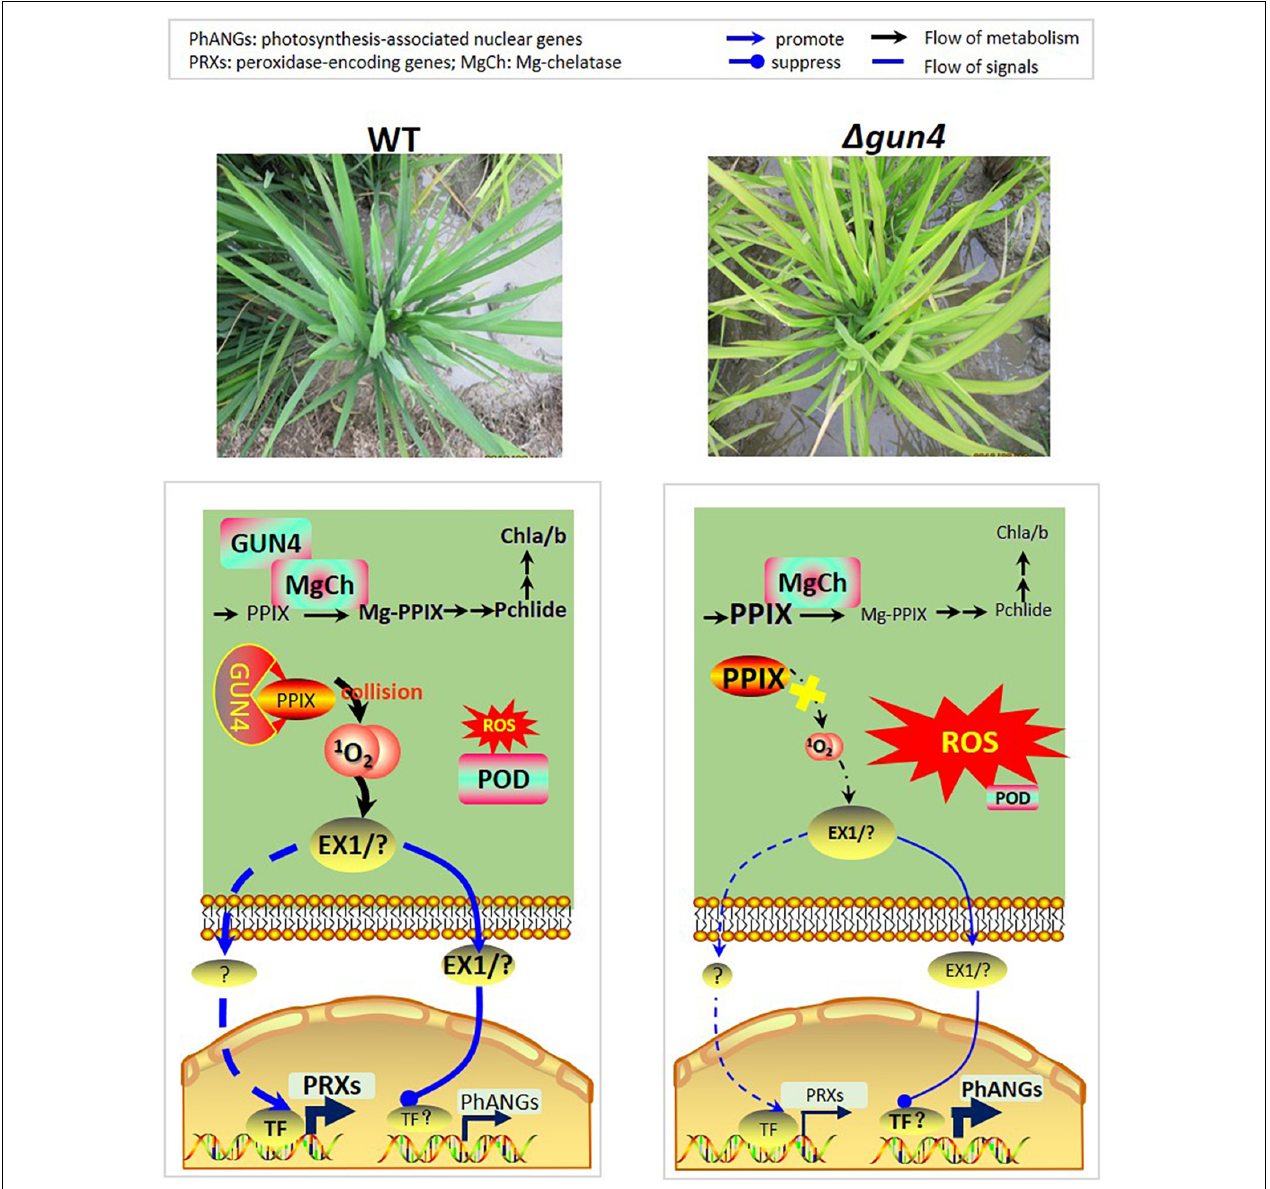
FIGURE 9 | Model explaining the roles of OsGUN4 during oxidative stress. In WT plants, the 1 O 2 level increases with the progress of photosynthesis, and activate EXECUTER 1 and/or EXECUTER 2 sense 1 O 2 level and other transcription factor genes, such as BAP1, but greatly repress the transcription of PhANGs. The transcription factors further activate downstream target genes including PRX genes, and the peroxidases encoded by them together help scavenge ROS thus maintain a low ROS levels. However, in gun4 mutants, the 1 O 2 level remains low due to lack of functional GUN4 hence the 1 O 2 -mediated retrograde signaling pathway is not activated, and consequently, (1) a relatively high level of photosynthesis is maintained, which continuously generates ROS, (2) PRX genes are not activated hence ROS scavenging capacity remains low, which together result in the accumulation of excessive ROS.